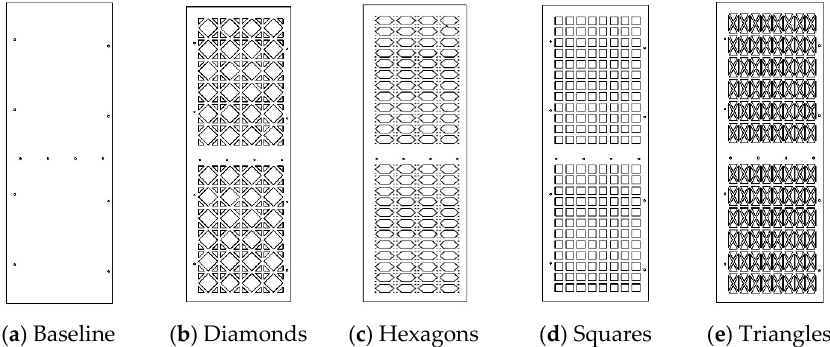
Figure 8. Scaled down and simplified central box plates.